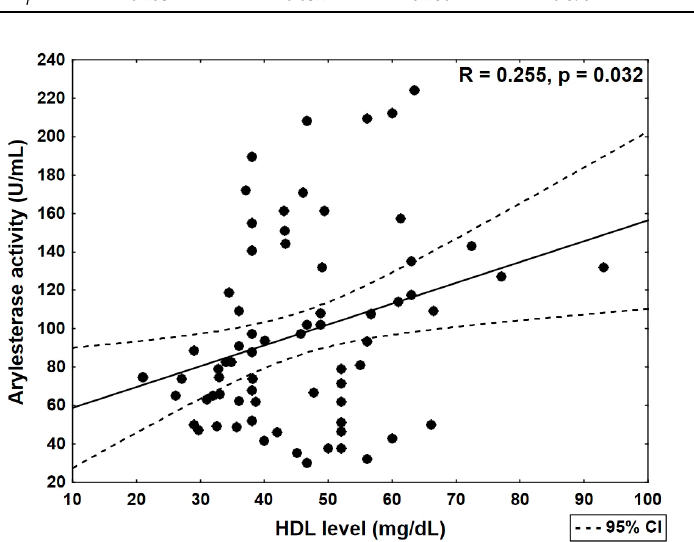
Figure 3. Correlation of HDL concentration and arylesterase activity in the group of patients with coronary heart disease (Spearman's rank test). CI, Confidence Interval.